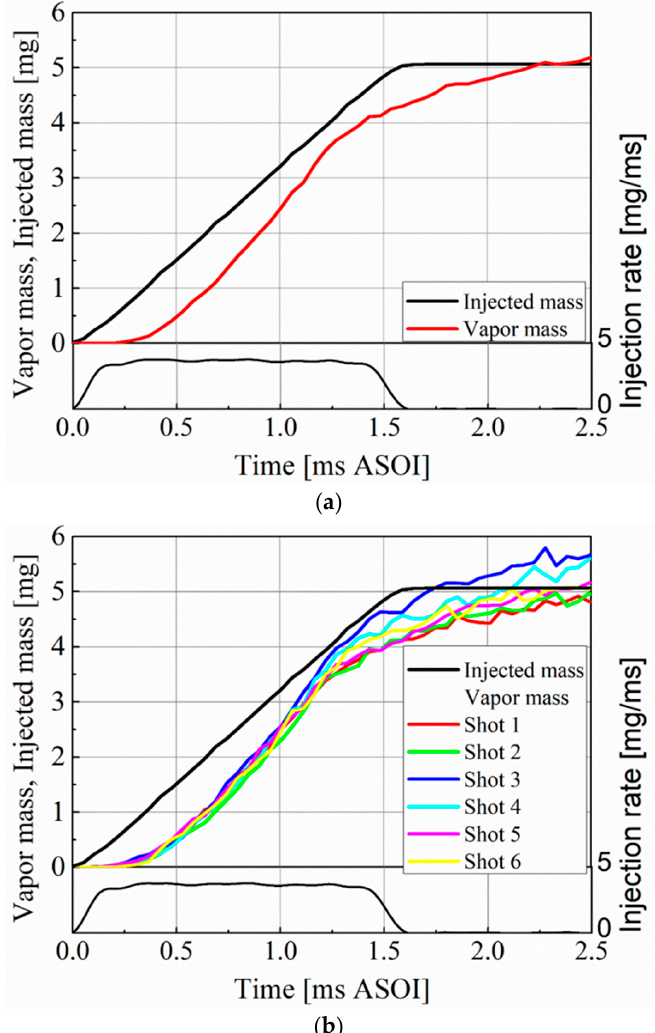
Figure 12. Temporal development of the vapor mass distributions (T a = 800 K, P a = 4.8 MPa, P inj = 100 MPa, M f = 5.0 mg). ( a ) Axisymmetric. ( b )